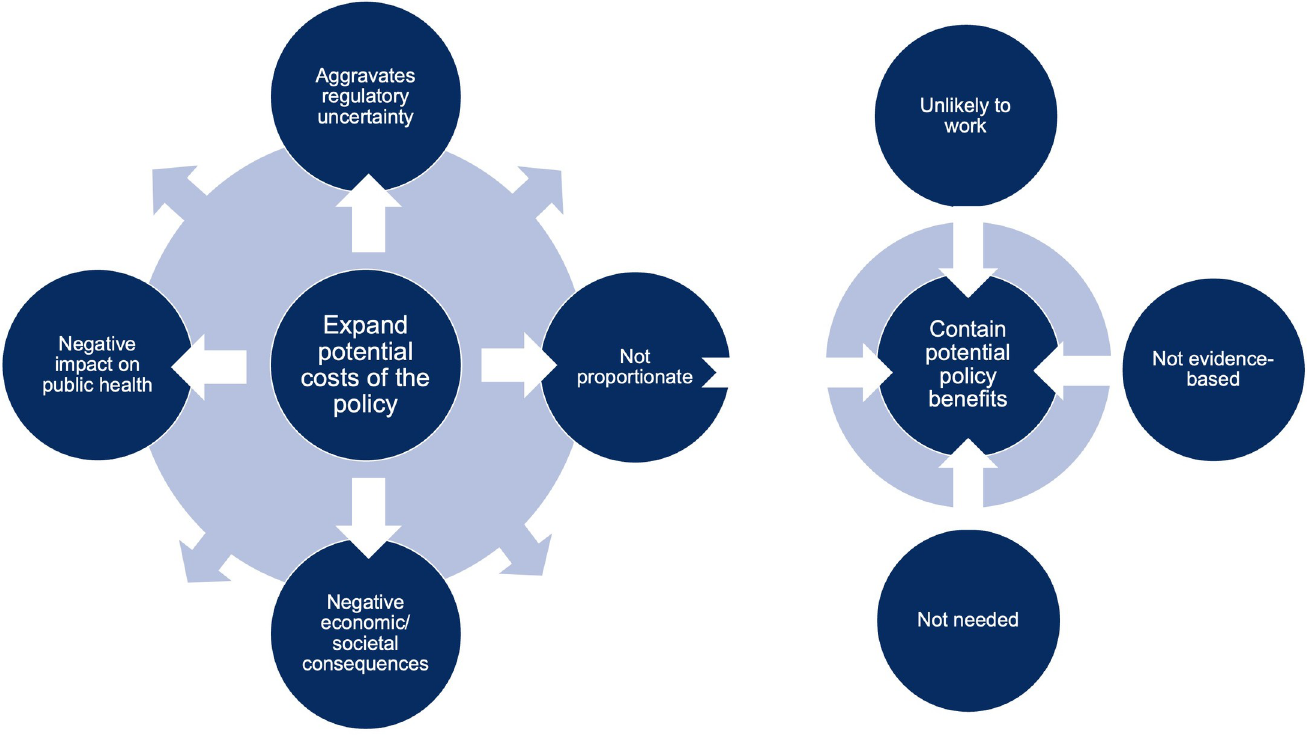
Fig 2. Discursive strategies used by food and advertising industry actors against the TfL advertising restrictions.